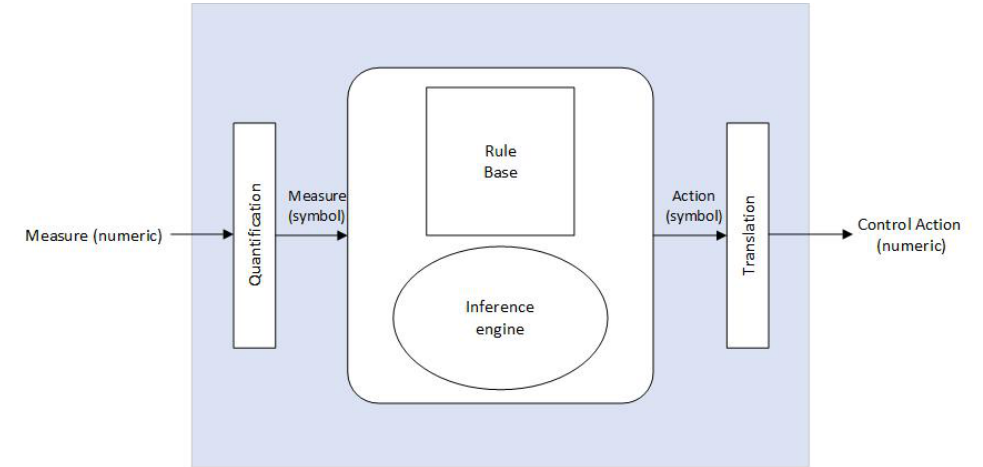
Figure 1. Feedback control system.